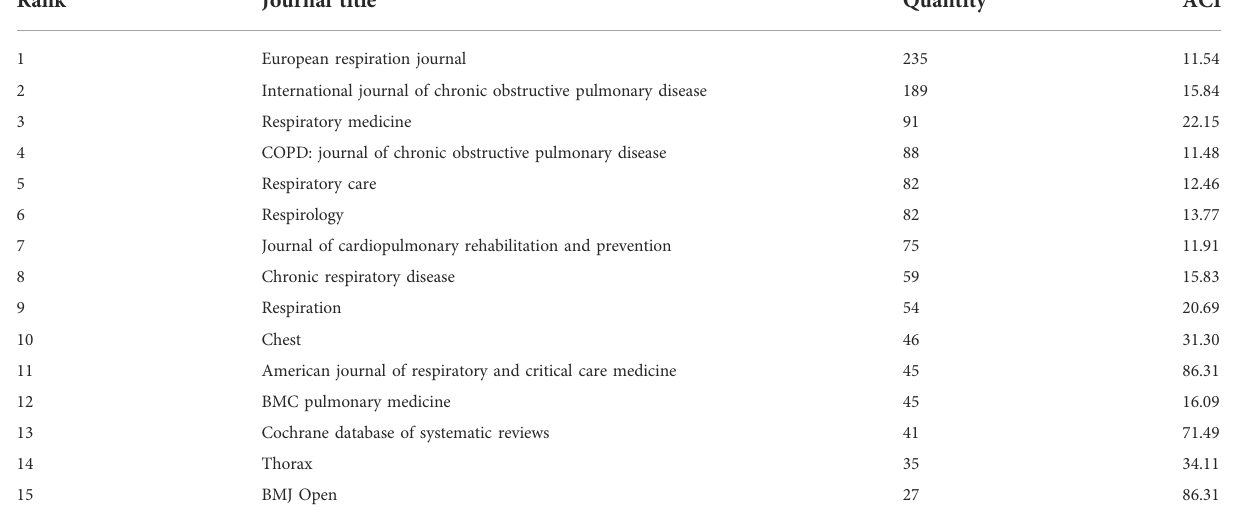
TABLE 5 Top 15 journals in the studies of COPD and exercise